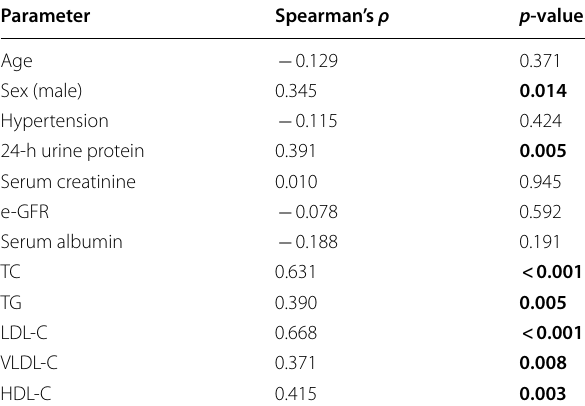
Table 3 Univariate correlations between serum PCSK9 levels and other parameters